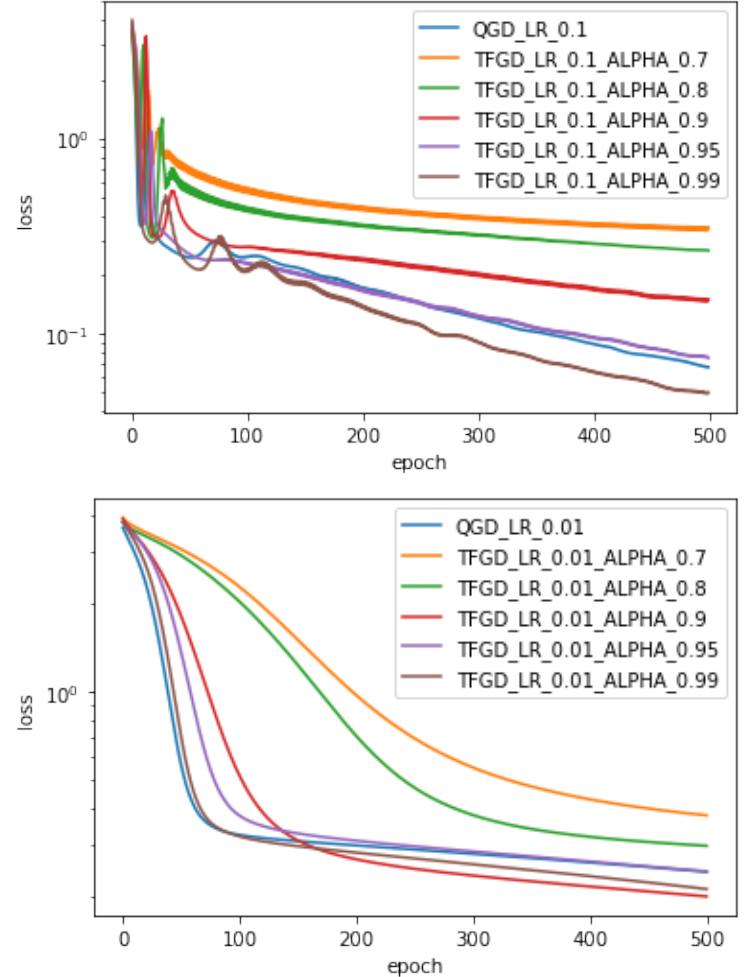
Figure 2. Comparison of loss effects for the learning rates η = 0.1,0.01, and different fractional order parameter α , where QGD and TFGD stand for the general gradient descent and the time-fractional gradient descent,